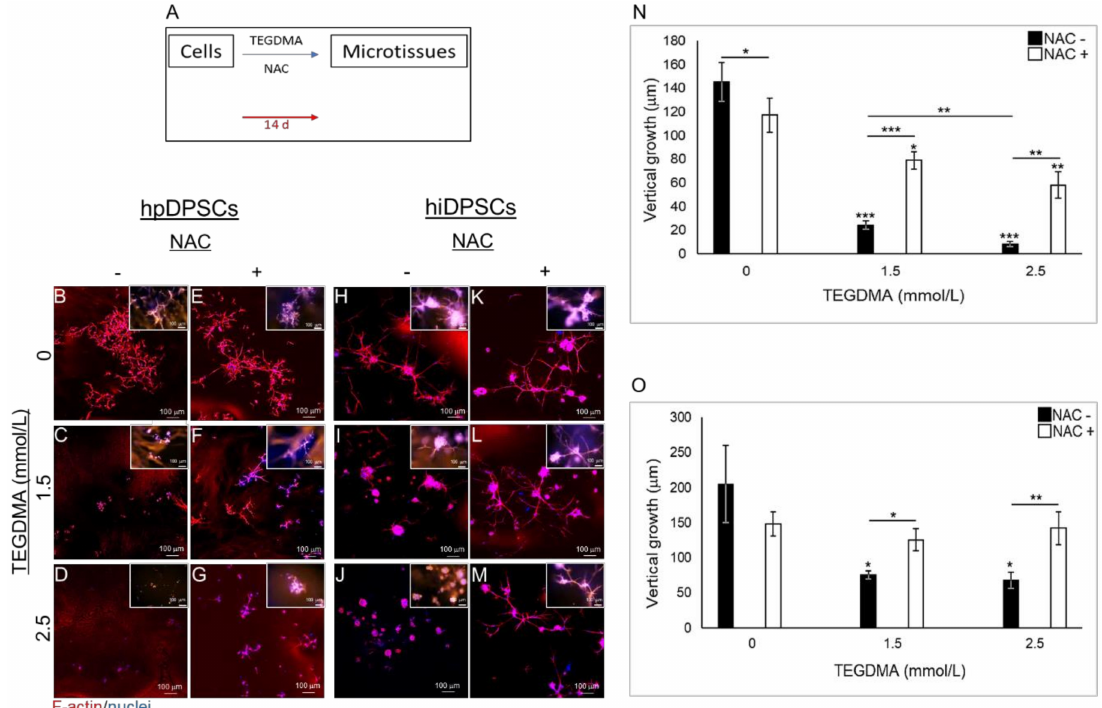
Figure 2. The spatial structure of developing microtissues exposed to TEGDMA and treated simultaneously with NAC. ( A ) Schematic diagram of the experimental assay. ( B – M ) Confocal images of ( B – G ) hpDPSCs and ( H – M ) hiDPSC microtissues ( B , E , H , K ) non-exposed versus exposed to ( C , F , I , L ) moderate and ( D , G , J , M ) high levels of TEGDMA treated with ( E – G , K , L , M ) NAC. ( N – O ) Bar graphs compare the thicknesses of ( N ) hpDPSCs and ( O ) hiDPSCs structures non-treated vs. treated